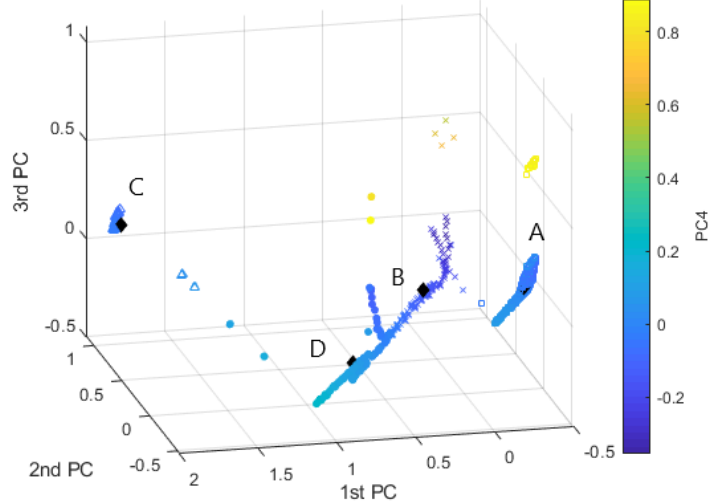
Figure 12. SC method. Clustering representation in the principal components scatterplot: Clust.A—“ (cid:3) ”, Clust.B—“ x ”, Clust.C—“ (cid:52) ”, Clust.D—“ ◦